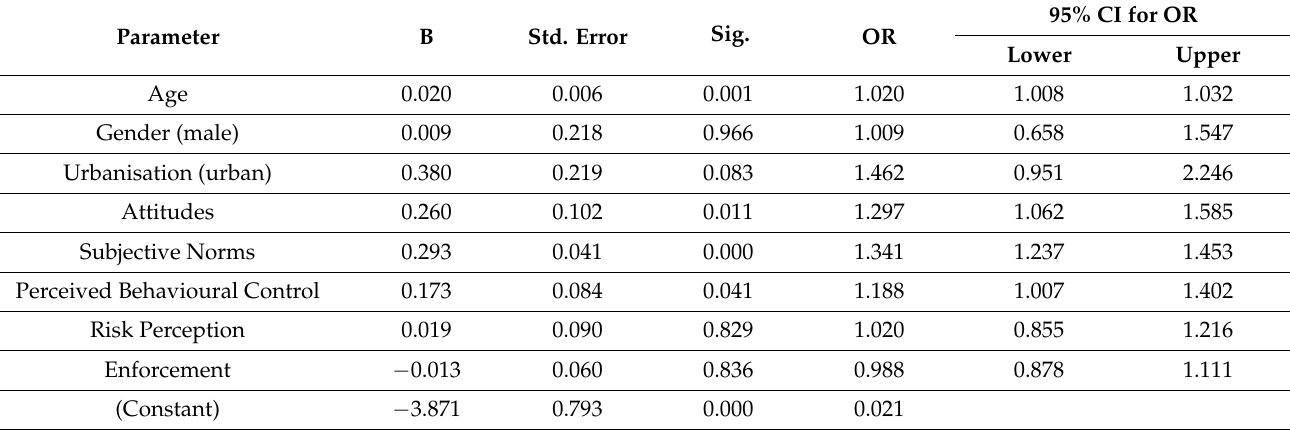
Table 7. Factors influencing speeding outside of built-up